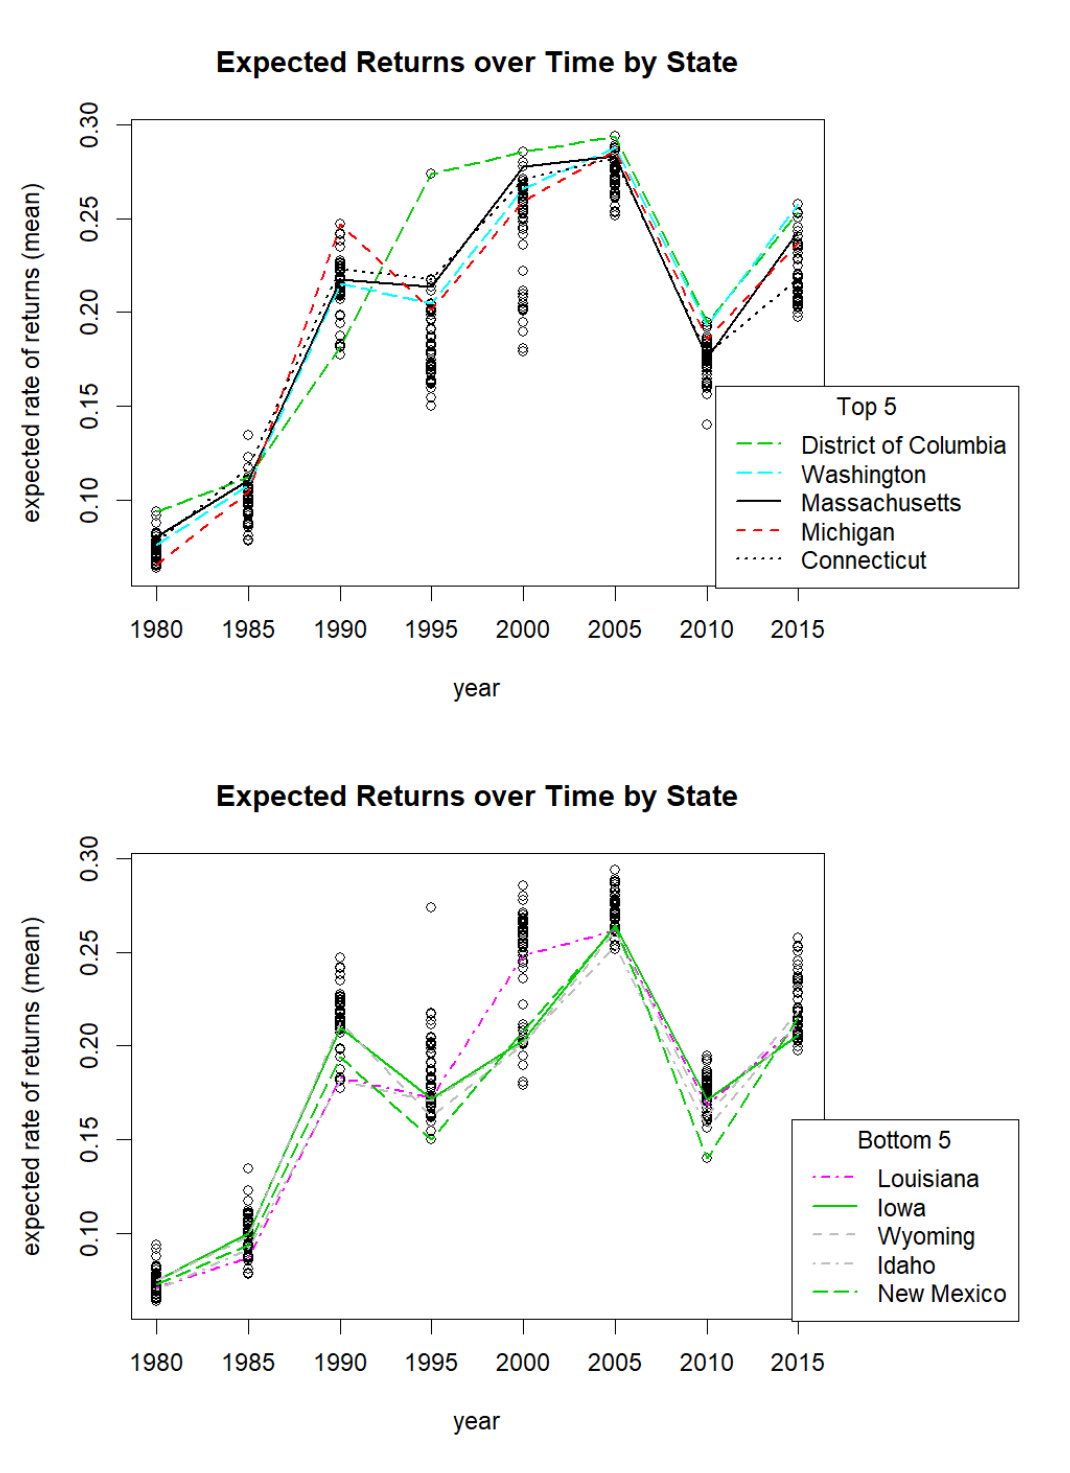
Figure 4. Expected returns top 5 and bottom